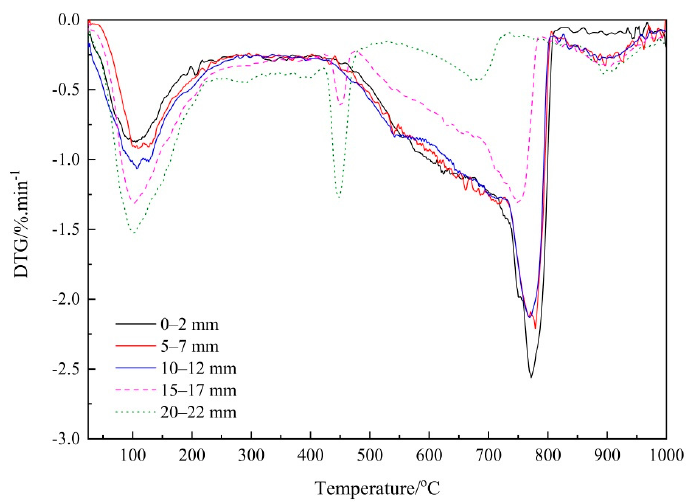
Figure 7. Derivative thermogravimetric (DTG) curves of the carbonated FA/PC paste samples at five depths.